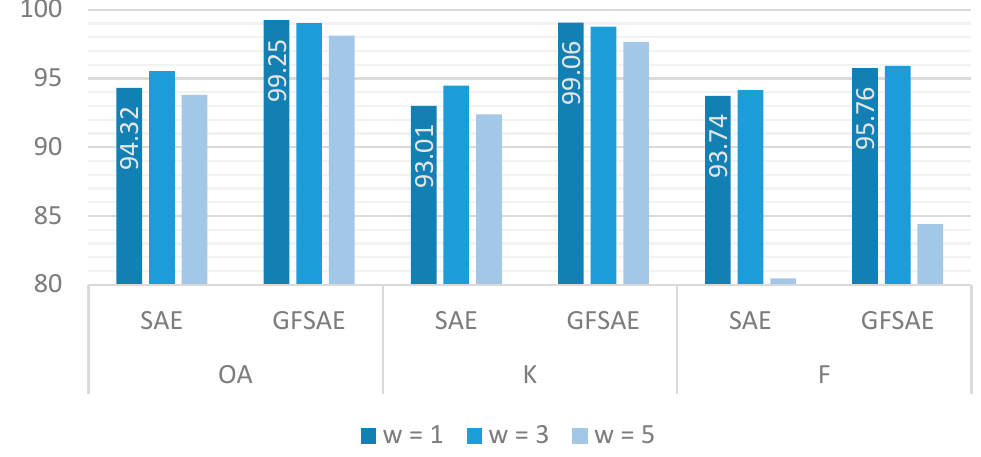
Figure 8. Accuracy metrics (OA, K, and F-score) for SAE and GFSAE obtained on the Winnipeg dataset. Figure 9 shows commission and omission errors for the Winnipeg dataset. As we see again, the superior performance of the proposed GFSAE framework is proved in reducing both commission and omission errors of different crop types except the broadleaf class. The broadleaf class has a minimal spatial extent, and hence filtering process mixes its information with other classes. Its lower amount of training data compared to other classes (see Table 2) aggravates this crop class’s challenging situation, leading to its higher omission